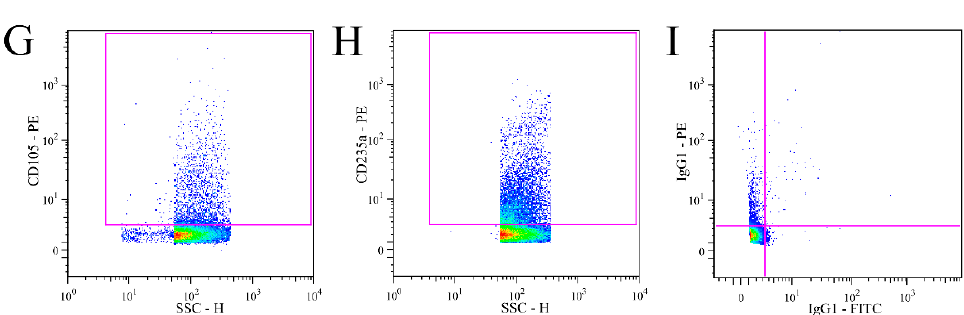
Figure 3. Definition of lEVs gate and representative results of lEVs labelling. ( A ). ApogeeMix beads were used to set lEVs gate to size of the beads. The mix consisted of 180 nm, 240 nm, 300 nm (below sensitivity), 590 nm, 880 nm and 1,300 nm silica beads with refractive index 1.43 and 2 latex beads (110 nm and 500 nm) with green fluorescence and refractive index 1.59. ( B ). An illustrative scattergram of isolated plasma vesicles with lEVs gate. Only events in the lEVs gate were included in the analysis. ( C – I ). Illustrative fluorescence dot plots showing representative results of lEVs labelling with: Annexin V FITC ( C ), CD36 FITC + CD41 PE ( D ), CD45 PaBl + CD3 FITC ( E ), CD45 PaBl + CD19 APC ( F ), CD105 PE ( G ), CD235a PE ( H ) and isotypic control IgG1 FITC + IgG1 PE ( I ).